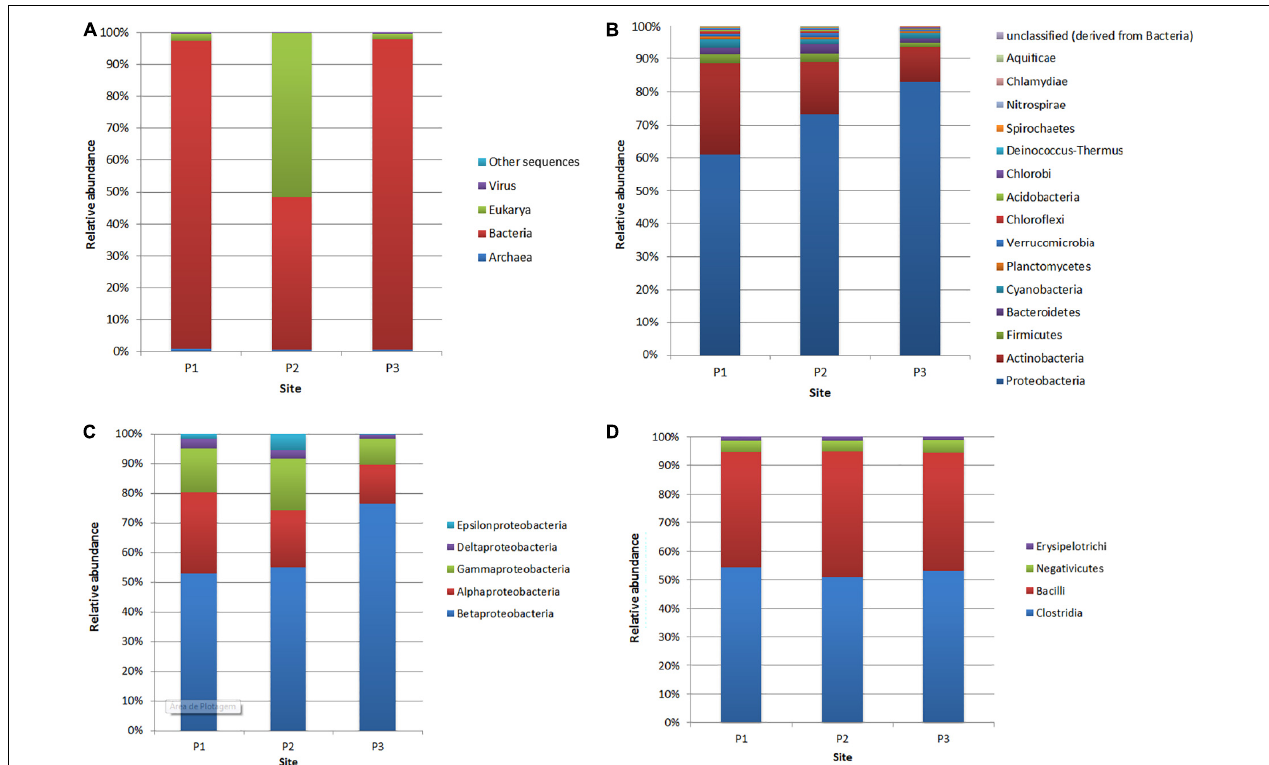
FIGURE 3 | Relative abundance of reads affiliated with domains (A) , bacterial phyla (B) , Proteobacteria classes (C) and Firmicutes classes (D) at the three sites (P1, P2, and P3).